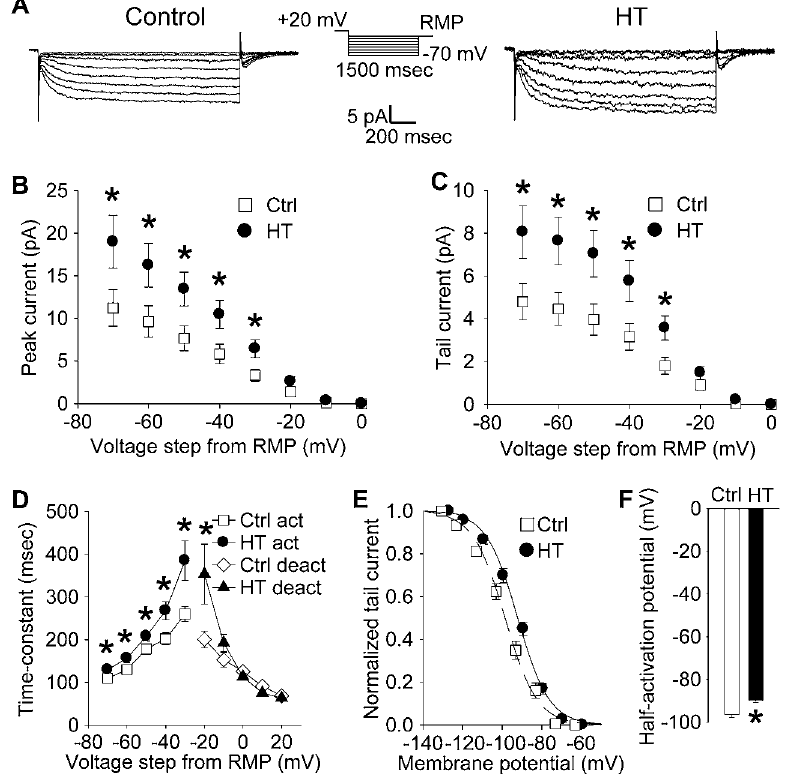
Figure 1. Increased h-current with altered kinetics in CA1 pyramidal apical dendrites following HT. (A) Dendritic cell-attached recordings of I 200 µm distance from the soma. Hyperpolarizing, 1500 ms long voltage commands from a holding potential 20 mV depolarized from rest produced slowly activating, non-inactivating inward currents characteristic of the h-current in control (left) and HT (right) dendrites. (B) Peak inward currents in control (open squares) and HT (fi lled circles) dendrites. (C) Tail currents from control (open squares) and HT (fi lled circles) dendrites. (D) Fitted activation (control, open squares; HT, fi lled circles) and deactivation (control, open diamonds; HT, fi lled triangles) time constants for the h-current. (E) Boltzmann activation curves for I fi tted to normalized tail currents from control (open squares) and HT (fi lled circles) dendrites. (F) Half activation potential for I (fi lled bar)